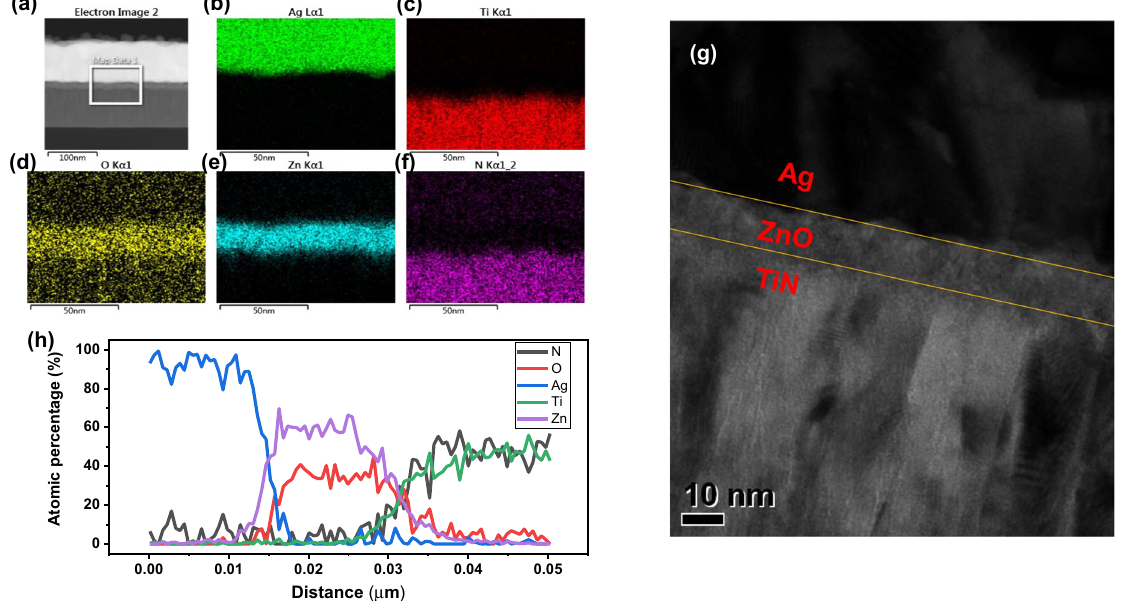
Figure 1. Material and chemical analyses of the Ag/ZnO/TiN device: ( a ) STEM image for EDS mapping. EDS mapping image with different elements: ( b ) Ag, ( c ) Ti, ( d ) O, ( e ) Zn, ( f ) N. ( g ) TEM image. ( h ) EDS line